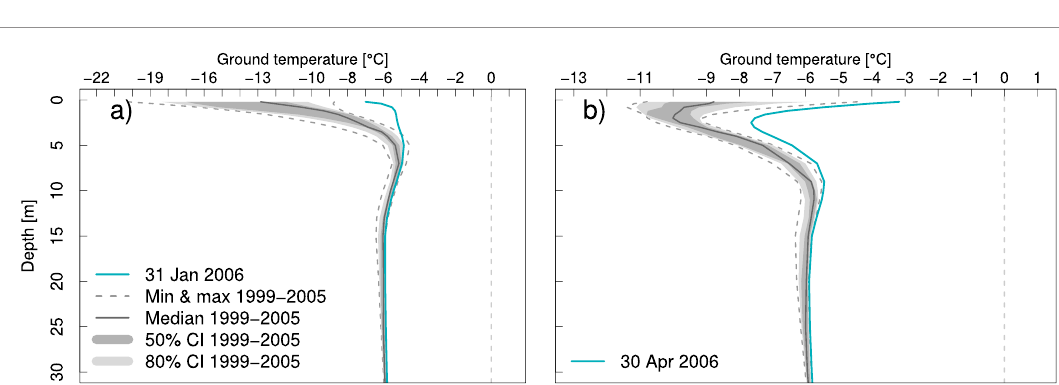
Figure 6. Ground temperature profile at Janssonhaugen on 31 January 2006 (a) and 30 April 2006 (b). The year 2006 is shown in blue, past minimum, maximum, median, and confidence intervals are shown in